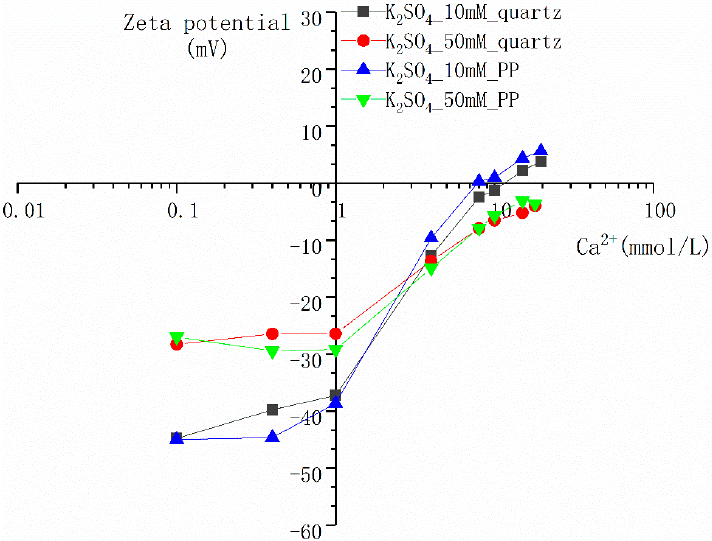
Figure 8. Evolution of the zeta potential of PP and quartz particles as a function of Ca 2+ concentration in 10 mmol/L and 50 mmol/L K 2 SO 4